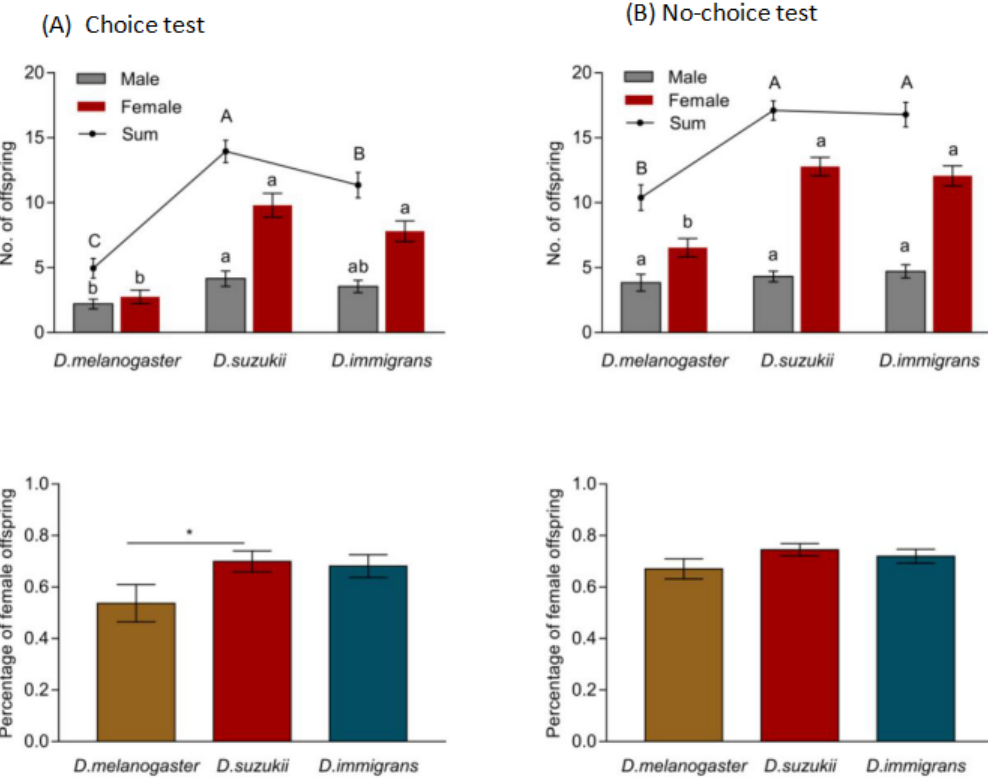
Figure 6. The number and sex ratios of emerged T. drosophilae offspring from different host species under choice and no-choice conditions. Different capital or lowercase letters and the asterisk indicate a significant difference between treatments (Tukey’s HSD, p < 0.05). Values are mean ± SE.